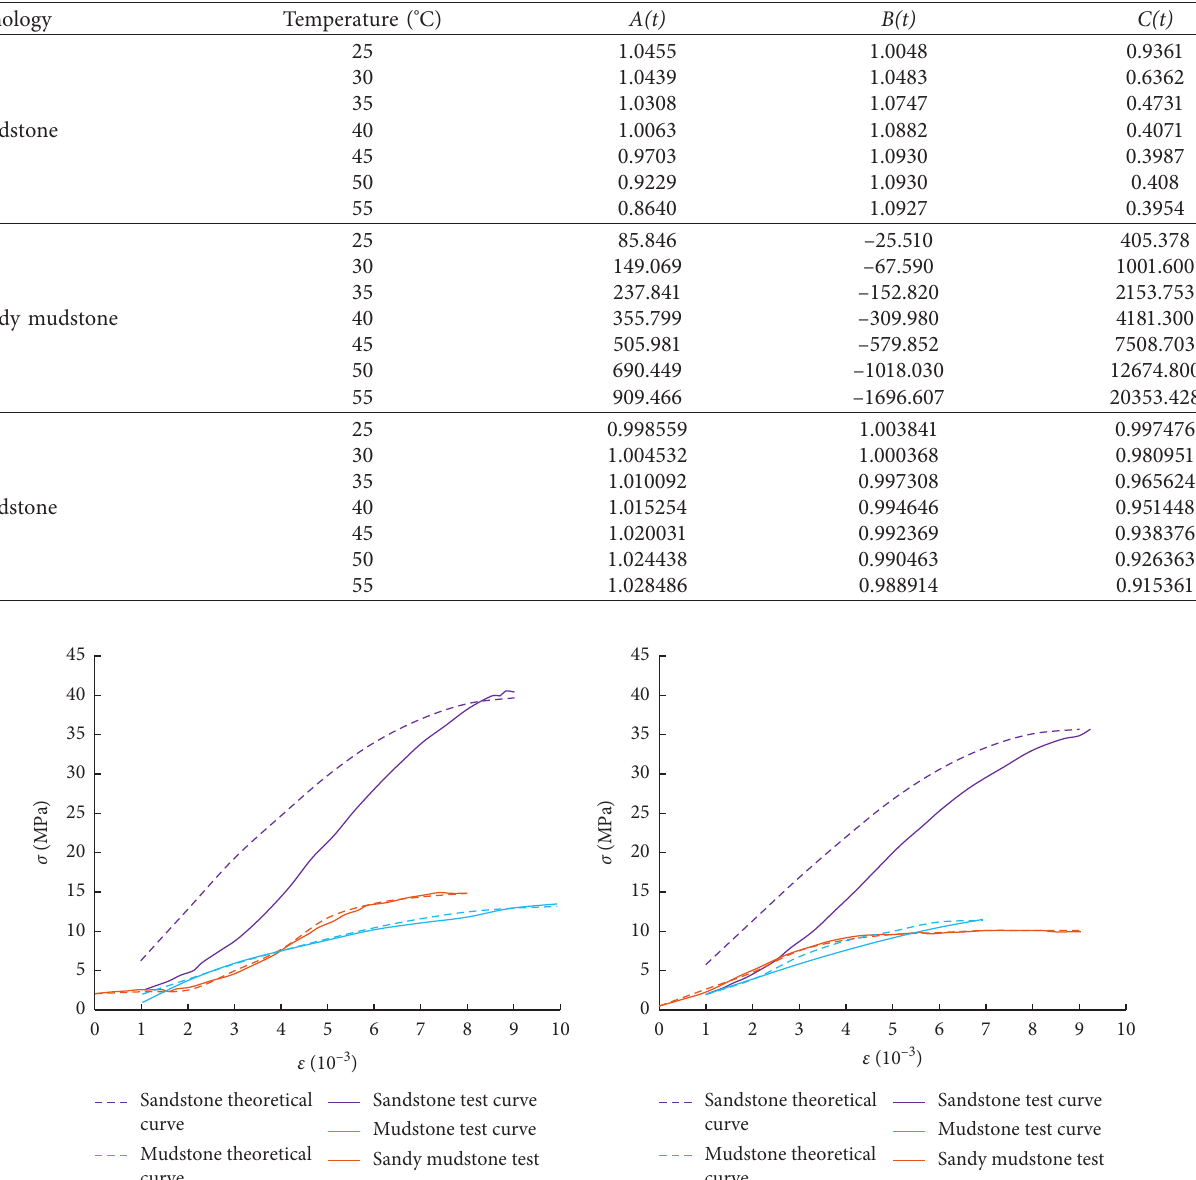
Table 3: Values of A(t) , B(t), and C(t) at each test temperature. Lithology